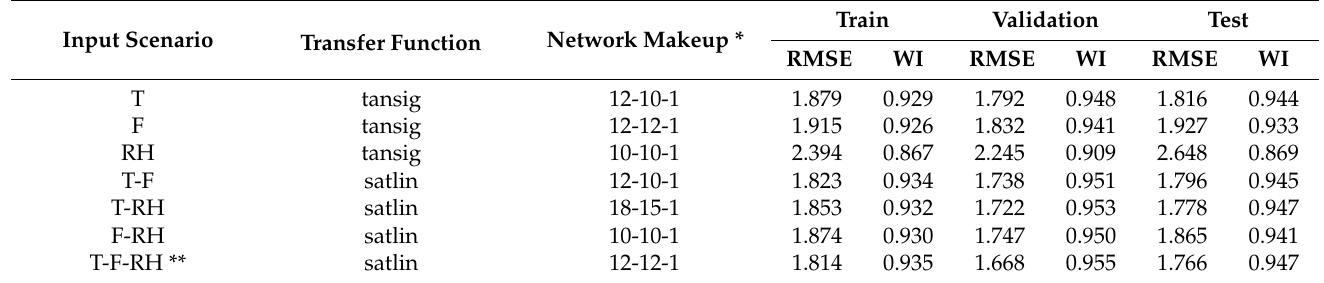
Table 5. Evaluation metrics for the pan evaporation modeling of MLP, learned by scaled conjugate gradient algorithm (MLP-SCG).